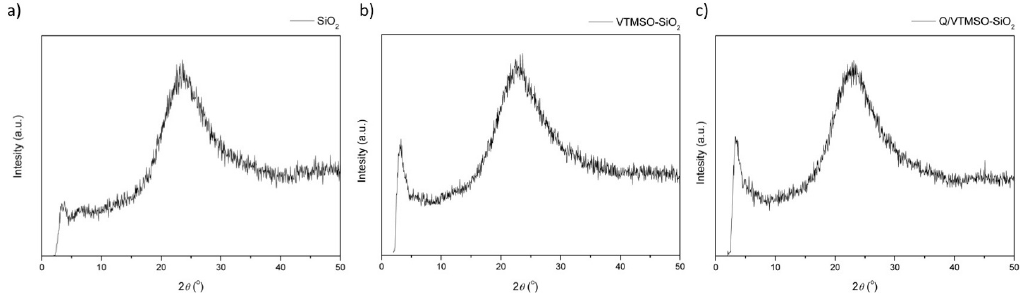
Figure 5. XRD patterns of SiO 2 ( a ), VTMSO-SiO 2 ( b ), and Q/VTMSO-SiO 2 ( c ).